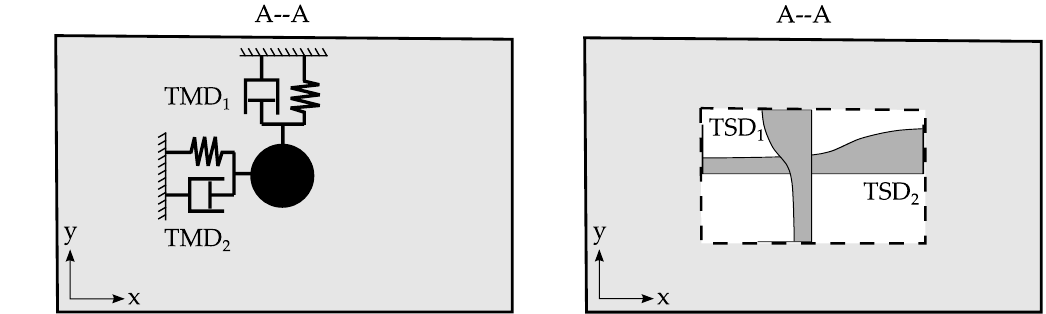
Figure 2. In-plane schematic representation of TMDs and